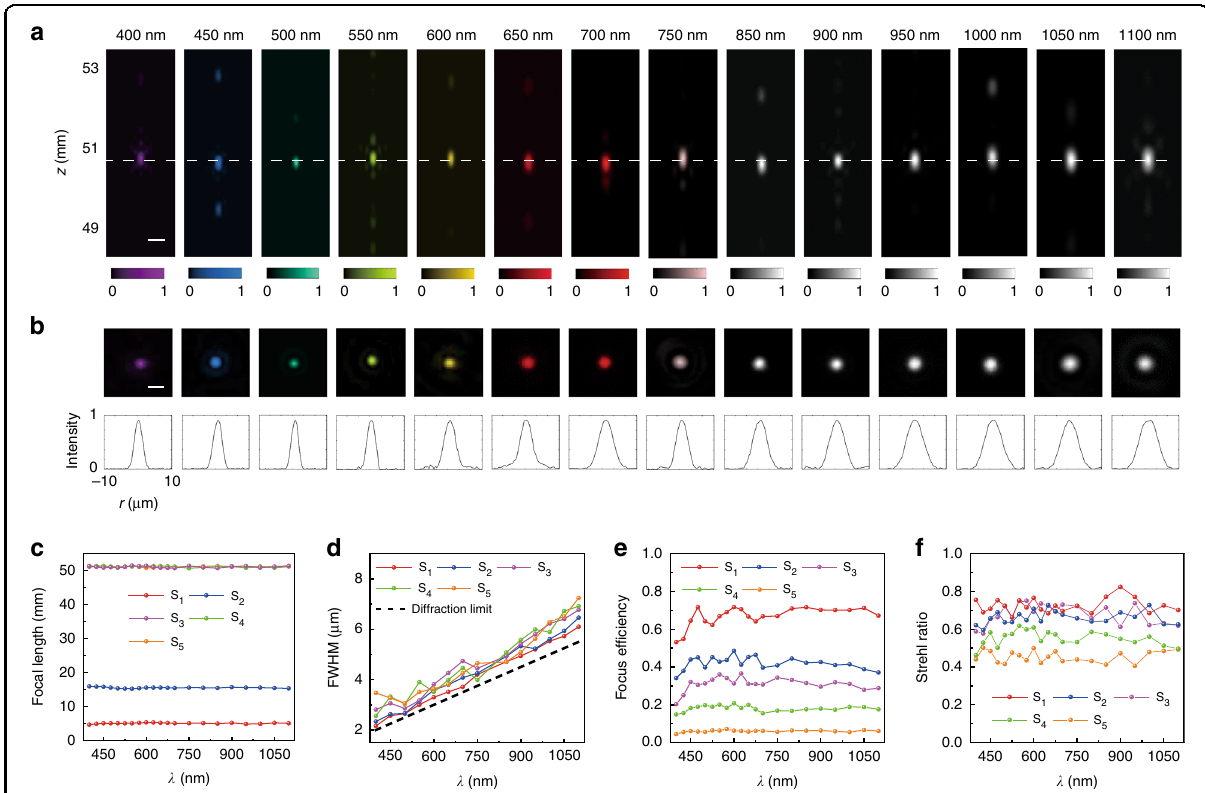
Fig. 4 Measured achromatic focusing characteristic of AMDLs. a Experimental light intensity pro fi les of sample S 3 at 14 different incident wavelengths. Scale bars, 15 μ m. b Normalized intensity pro fi les along the white dashed lines of a . Scale bars, 10 μ m. c Experimentally measured focal length shifts of samples S 1 -S 5 . d Experimentally measured FWHM of PSF of samples S 1 -S 5 and the diffraction limited FWHM (black dashed dots). e Measured focus ef fi ciencies of samples S 1 -S 5 . f Experimentally measured Strehl ratios of samples S 1 -S